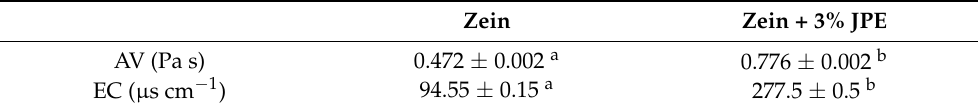
Table 2. Apparent viscosity and electrical conductivity of zein solutions. Zein Zein + 3%